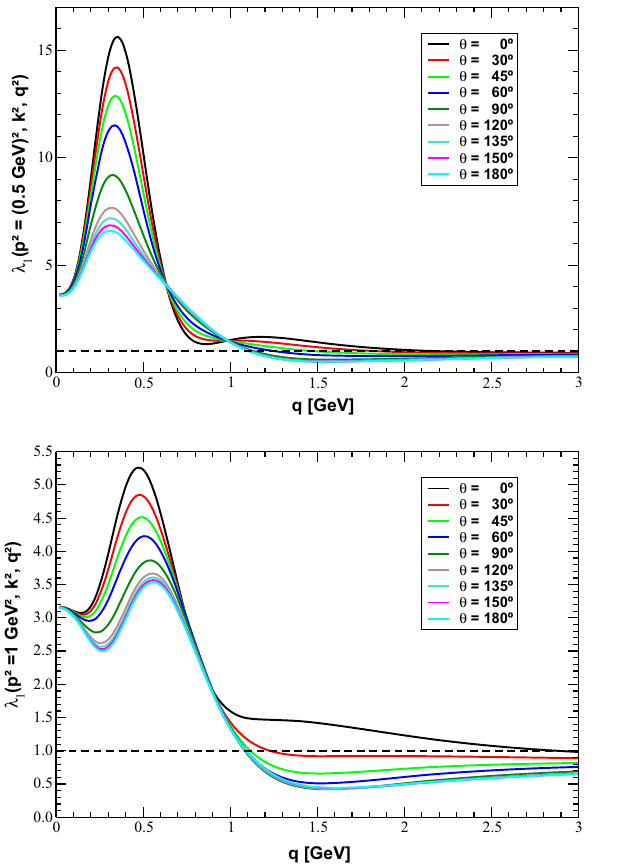
Fig. 39 λ 2 for p = 0 . 5 GeV (top) and p = 1 GeV (bottom) and various